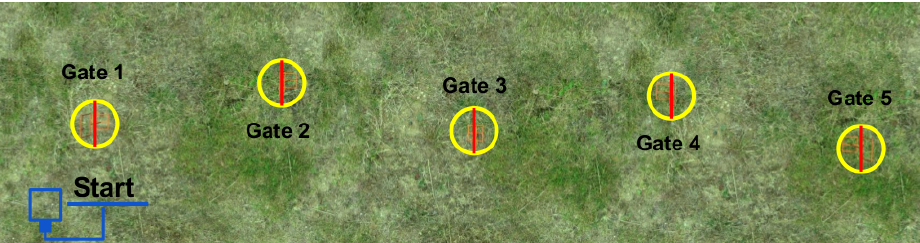
Figure 16. Zigzag racetrack in Gazebo to evaluate our proposed DeepPilot architecture and compared against PoseNet [6]. The track spans over a surface of 60 m . × 7 m , with 11m. of space in between gates. We evaluated: (1) PoseNet trained to predict the 4 flight commands ( φ , θ , ψ , h ) ; (2) PoseNet trained to predict only ( φ , θ ) ; (3) DeepPilot trained to predict the 4 flight commands. We used a mosaic image composed of 6 frames as image input to the